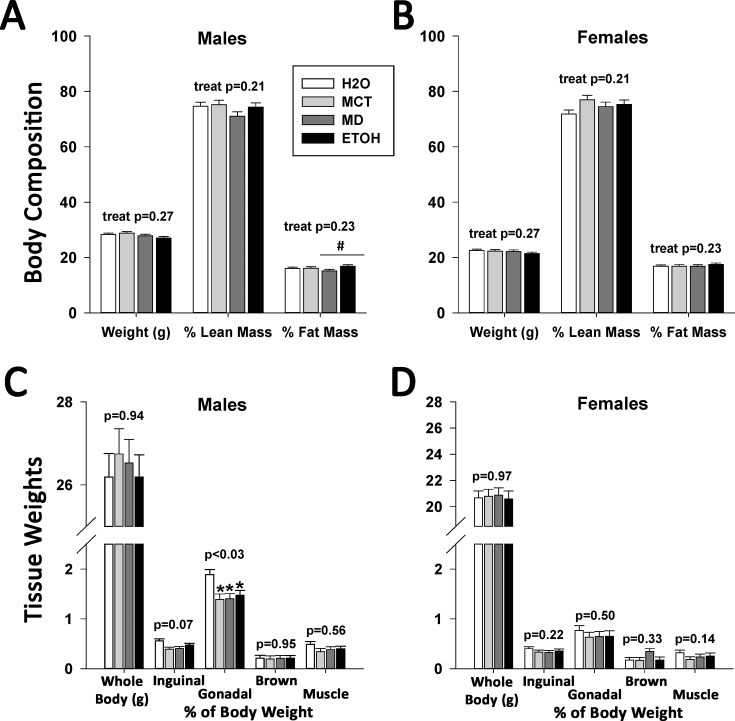
Isocaloric treatment, but not PAE, alters fat mass in adult male but not female mice.(A) Body composition (% lean mass, % fat mass) was quantified in control and alcohol-treated offspring using DXA. At age 17 weeks, male offspring had similar body weights and lean mass content, expressed as a percentage of body mass, regardless of prenatal treatment. However, ETOH males had significantly greater fat mass compared with MD males. (B) At age 17 weeks, female offspring had similar body weights, lean mass content, and fat mass content, expressed as a percentage of body mass, regardless of prenatal treatment. (C) In a separate cohort of males dissected for tissue collection at age 17 weeks, prenatal treatment did not affect total body weight, brown fat mass, and gastrocnemius mass, the latter two expressed as a percentage of body mass. However, male offspring in all three added-calorie groups (MCT, MD, ETOH) had a significantly decreased inguinal fat pad mass in comparison with H2O males (p<0.05). (D) In females, there were no ETOH or treatment effects upon body weight, or fat pad and gastrocnemius mass as a percentage of body weight. Values are mean ± SEM of 10–12 offspring per sex*treatment group. * p<0.05 vs. H2O, # p<0.05 vs. MD, using mixed linear factorial analysis of variance, followed by slice-effect ANOVAs with a priori hypotheses allowing for planned comparisons.